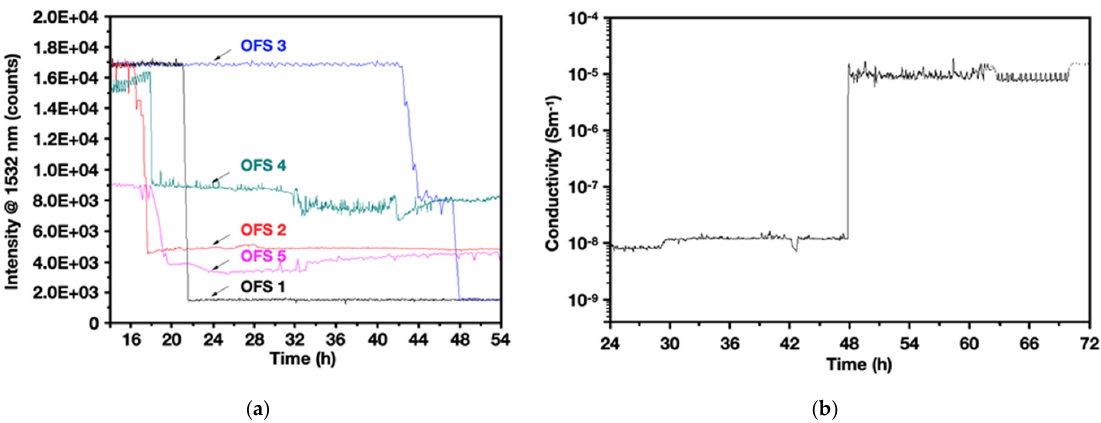
Figure 7. ( a ) Signal intensity at a wavelength of 1532 nm from the optical fibre sensors (OFSs), ( b ) continuous monitoring of the conductivity signal of the GF ply, spray coated with CNT, positioned at depth of 2.2 ± 0.3 mm: signal increased after 48 h. The composite was immersed in artificial sea water at 80 ◦ C for 7